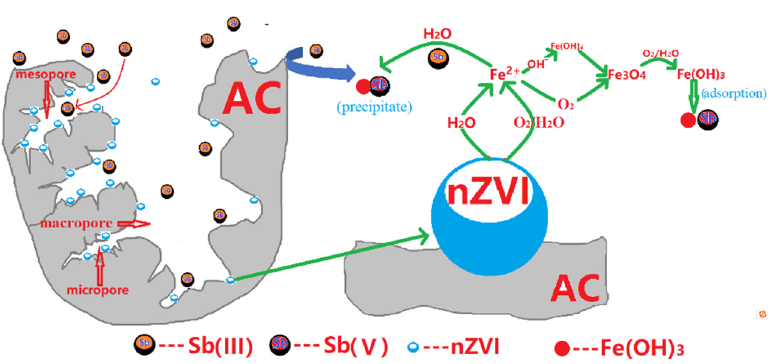
Figure 6. Illustration of the major reactions occurring in the nZVI/AC-H 2 O-O 2 system and oxidation and sequestration mechanisms of Sb(III).